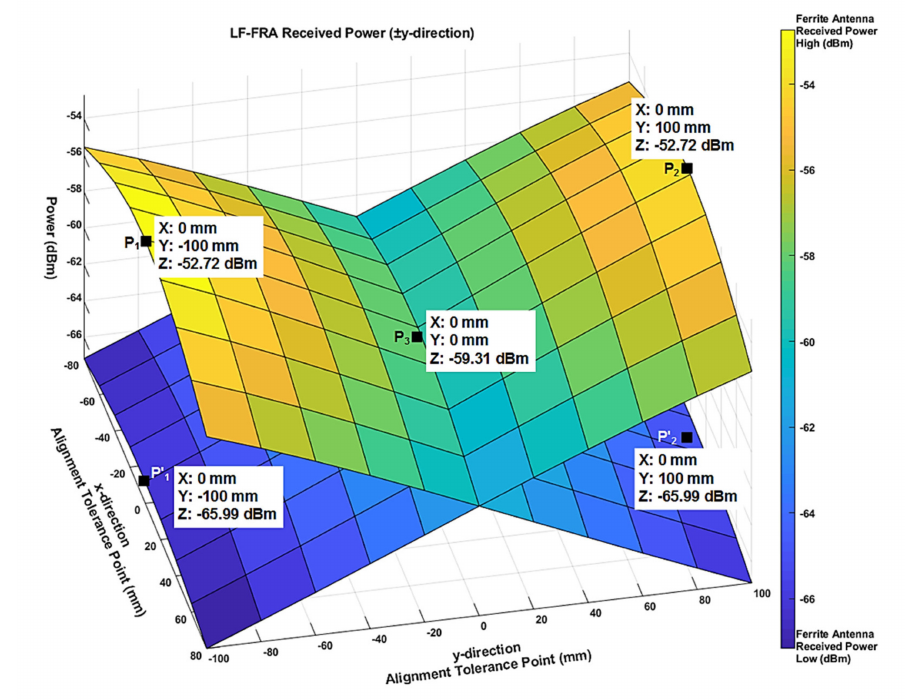
Figure 17. Simulation results for power received by the ferrite antenna receiver of the + y-direction and − y-direction.